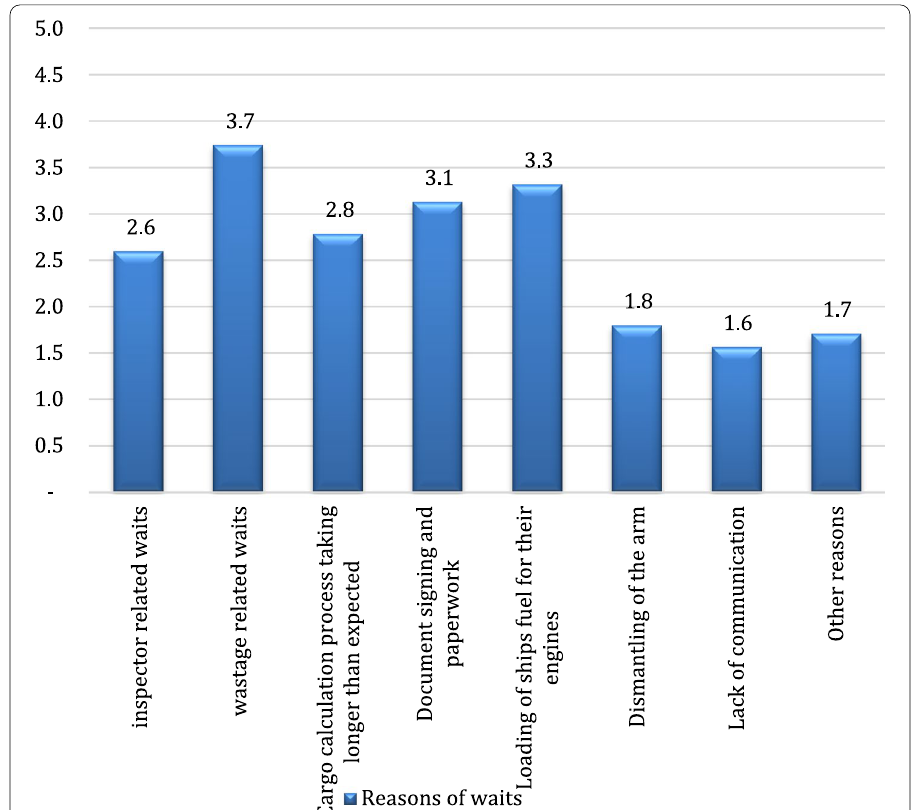
Fig. 5 Reasons for the waits upon the completion of loading or unloading